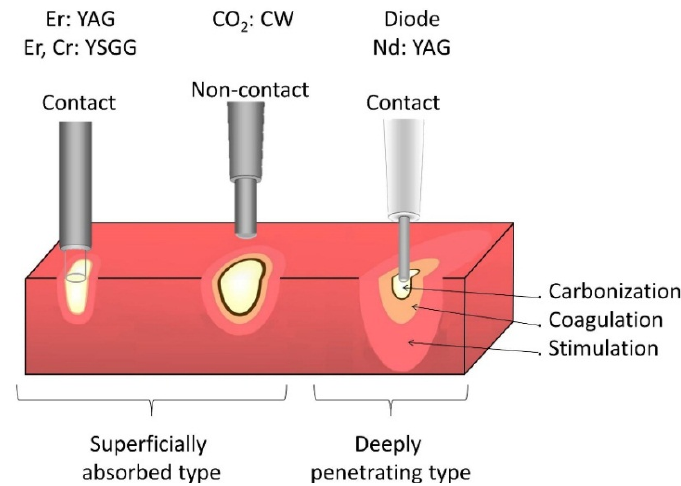
Figure 4. Schematic representation of the classification of lasers, according to penetration depth in biological tissue and their effects (adapted from